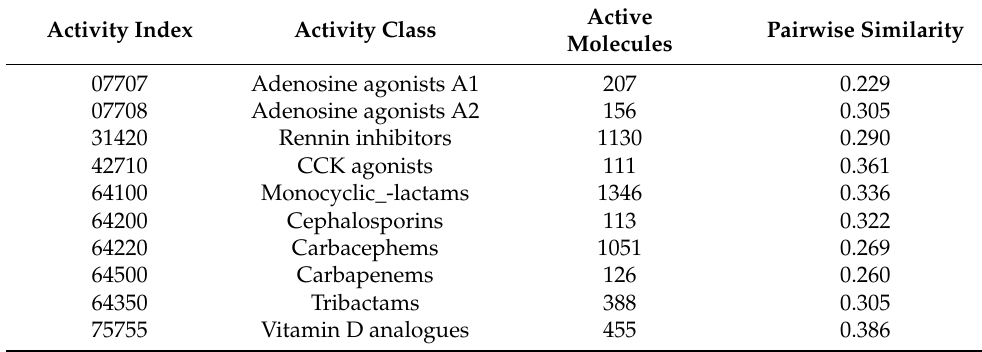
Table 5. MDDR activity classes for DS1 dataset.